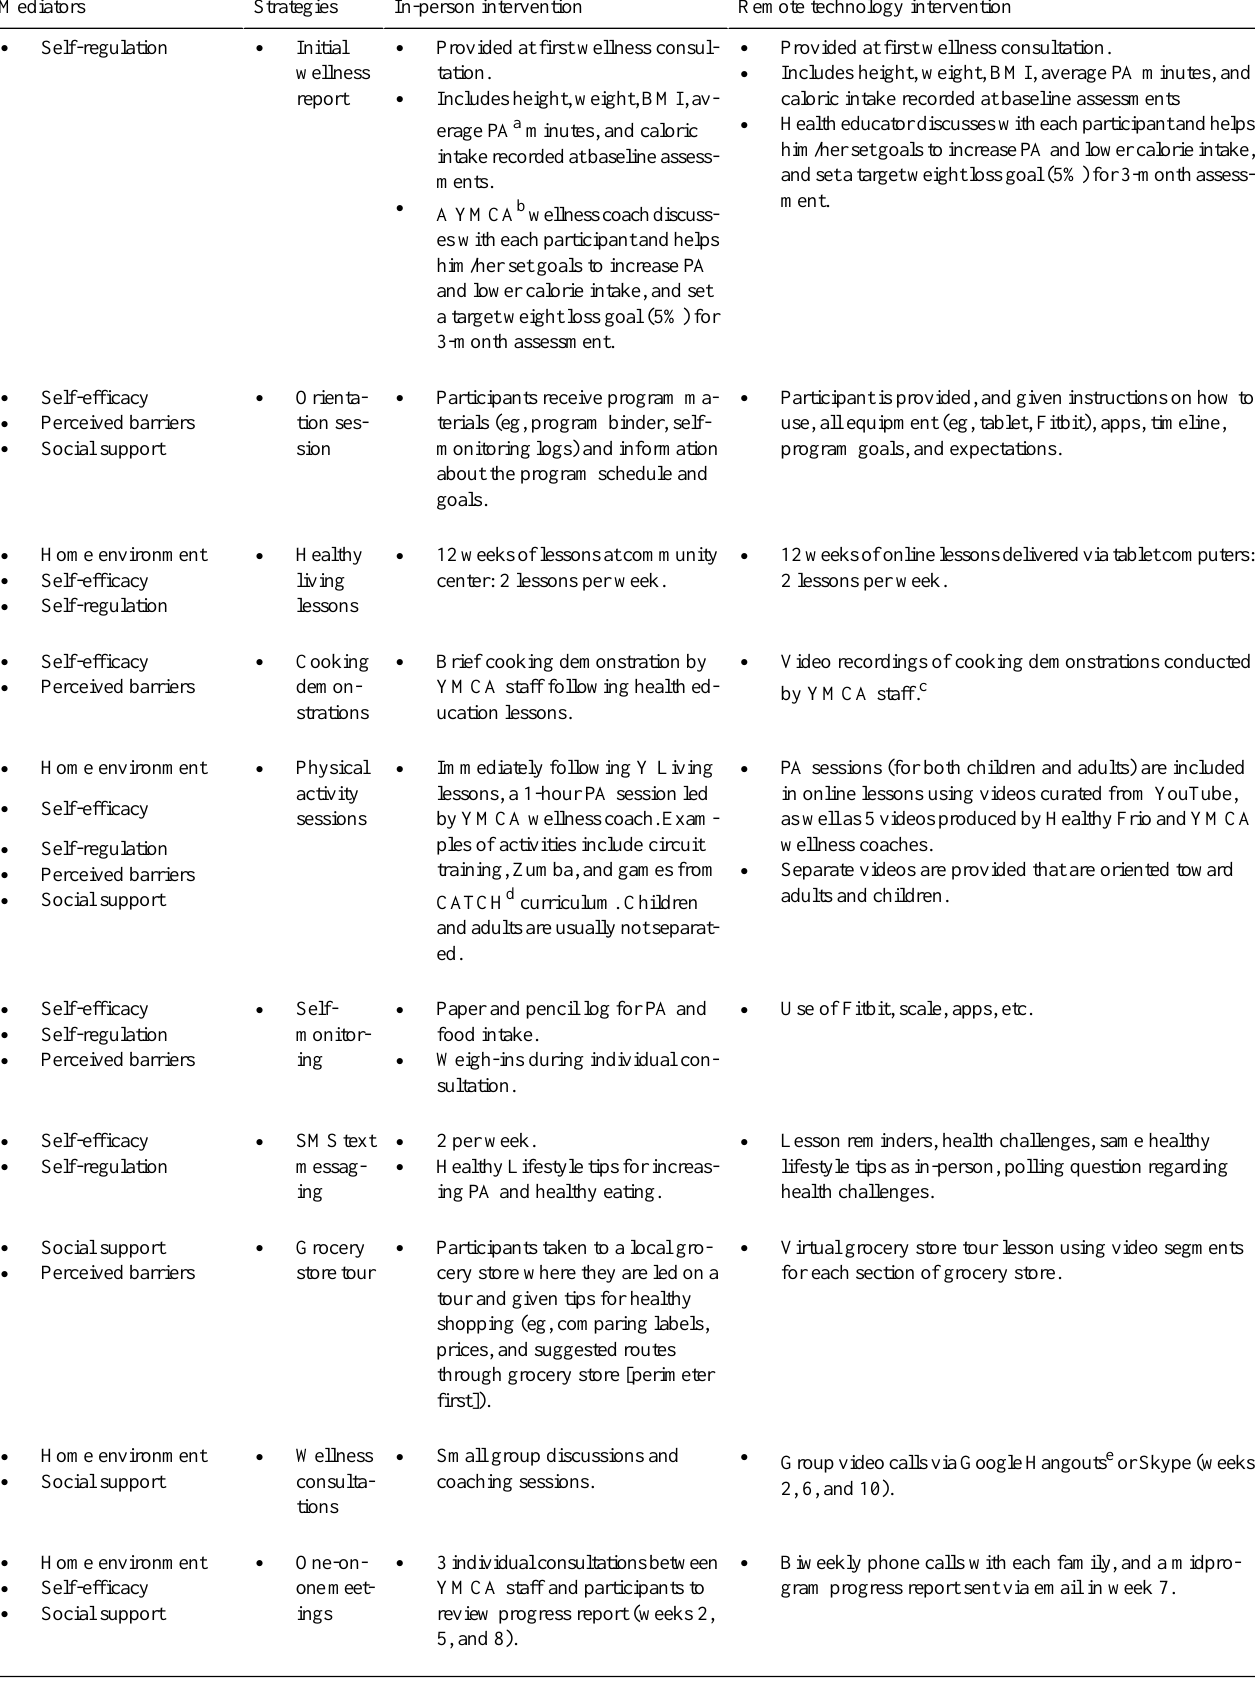
Table 1. Description of and alignment between in-person and remote technology